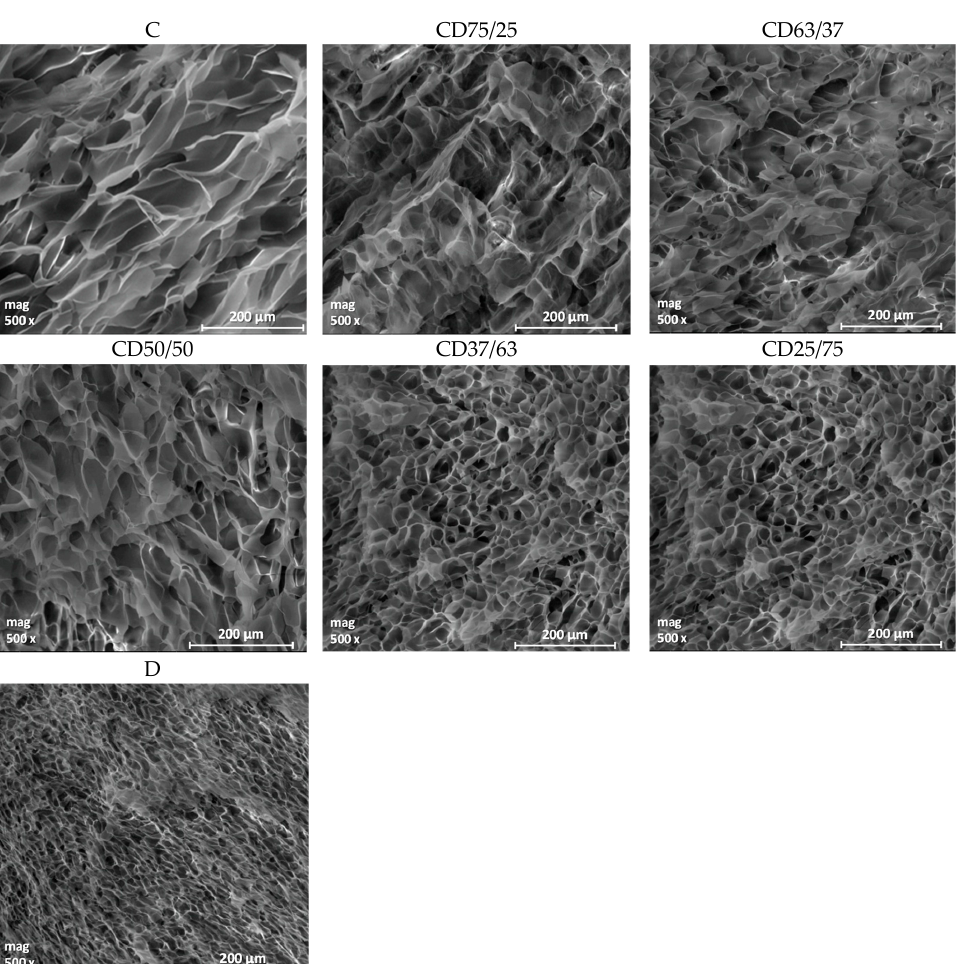
Figure 2. Swelling kinetics curves of the hydrogels, as a function of composition.